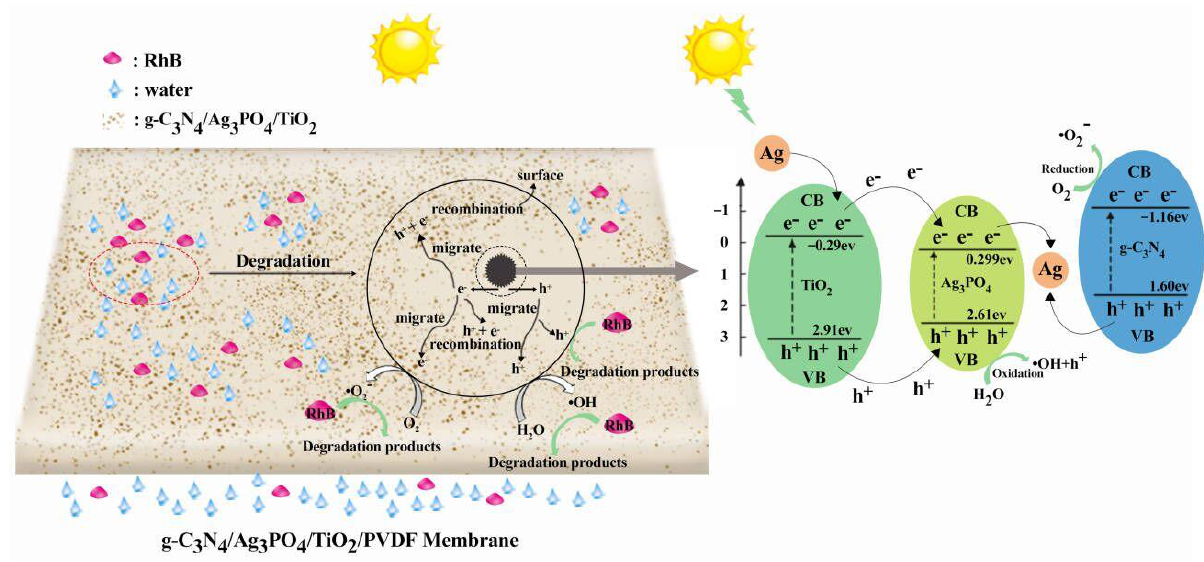
Figure 11. Photocatalytic degradation process in the g-C 3 N 4 /Ag 3 PO 4 /TiO 2 /PVDF